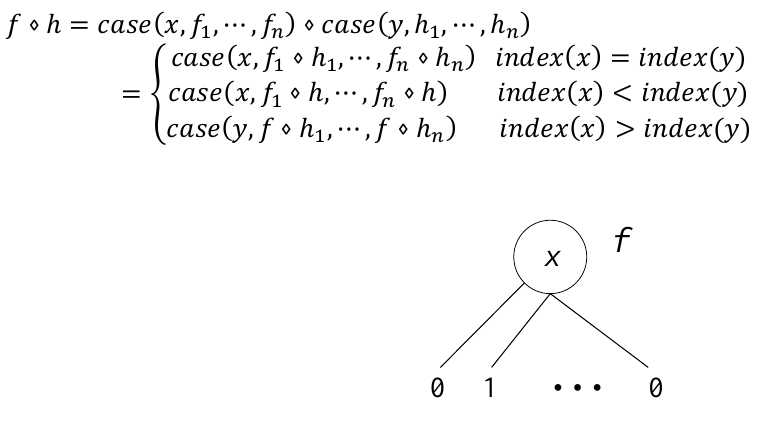
Figure 2. Illustrative basic event